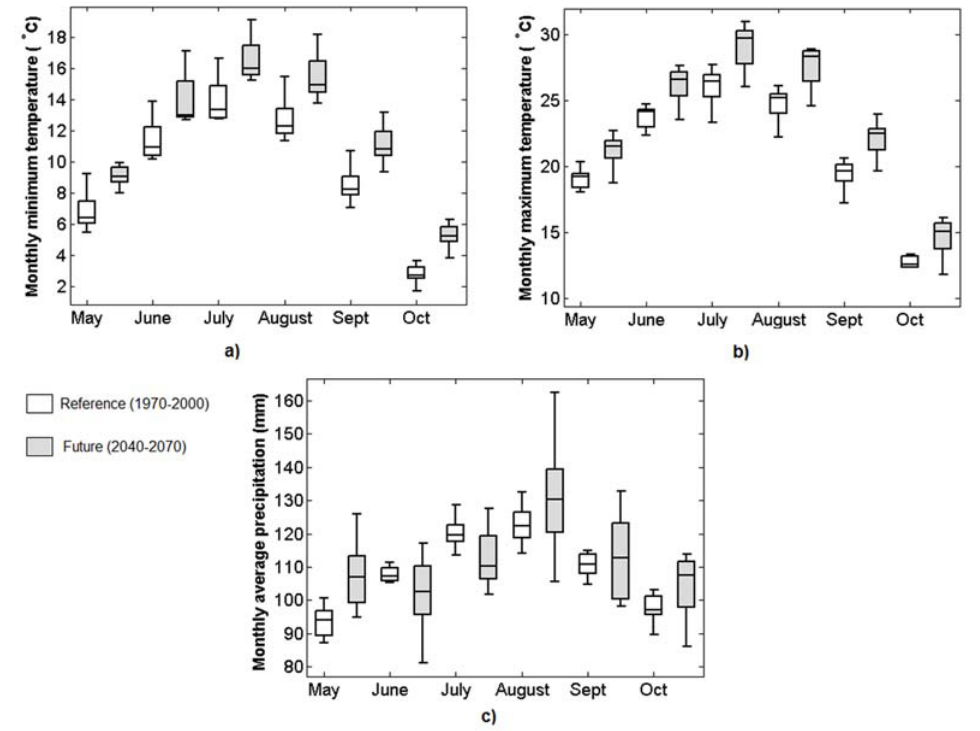
Figure 3. Uncertainties related to the climate model for the ( a ) monthly minimal temperature; ( b ) monthly maximal temperature; and ( c ) precipitation for the Yamaska River watershed. Boxes represent the 25–75 percentile values. Whiskers correspond to the 5–95 percentile values.